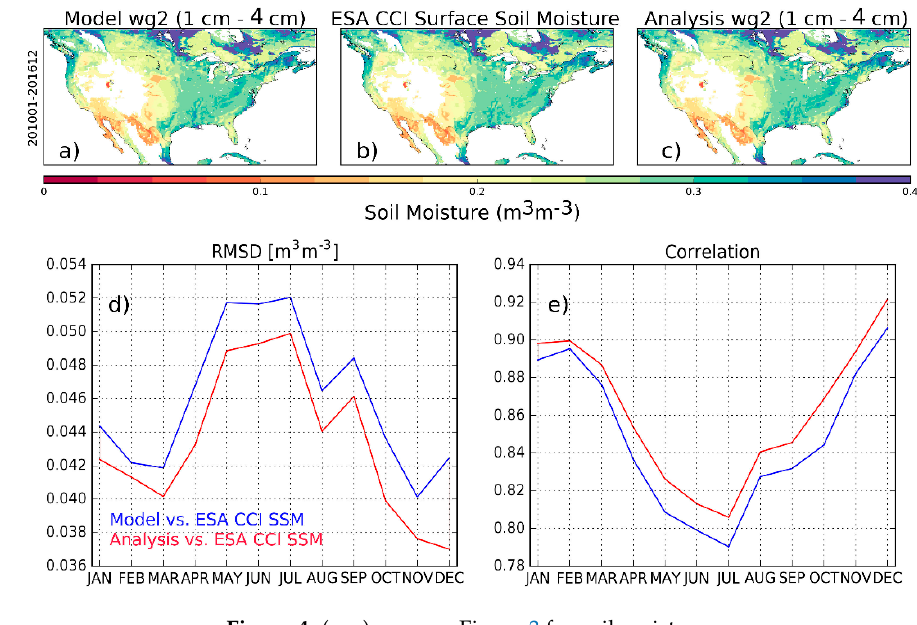
Figure 4. ( a – e ) same as Figure 3 for soil moisture.